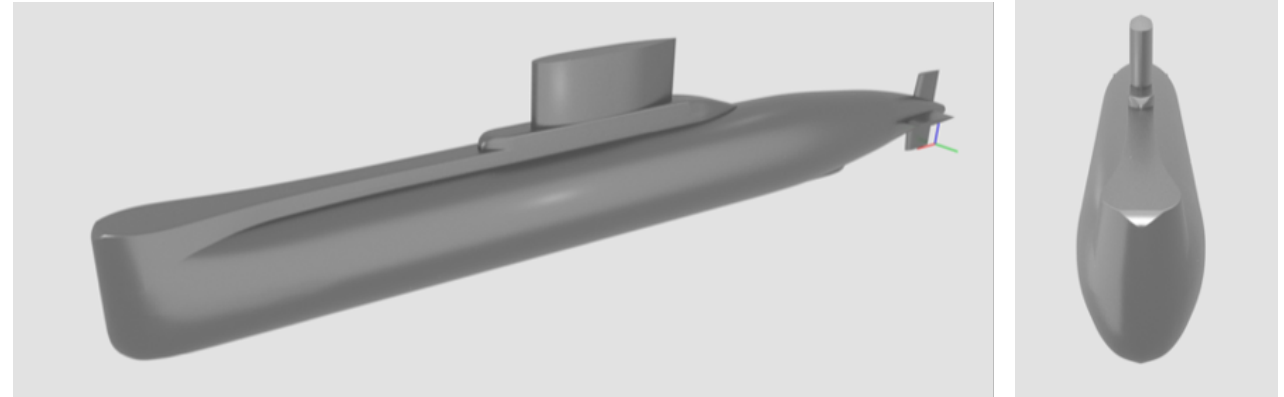
Figure 3. Simplified 3D CAD model of Type 209/1300 submarine used in the present